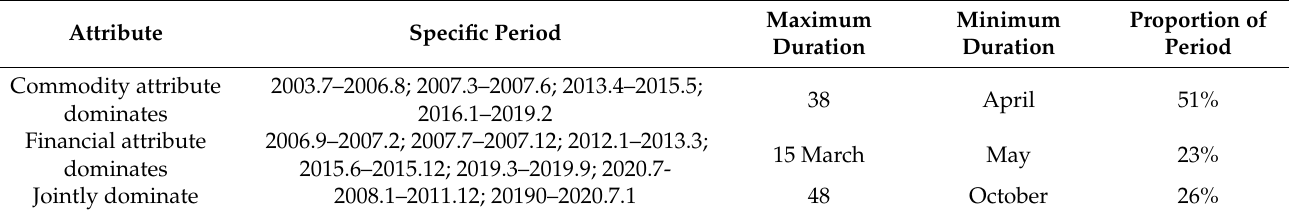
Table 1. Stage characteristics dominated by dual attributes of